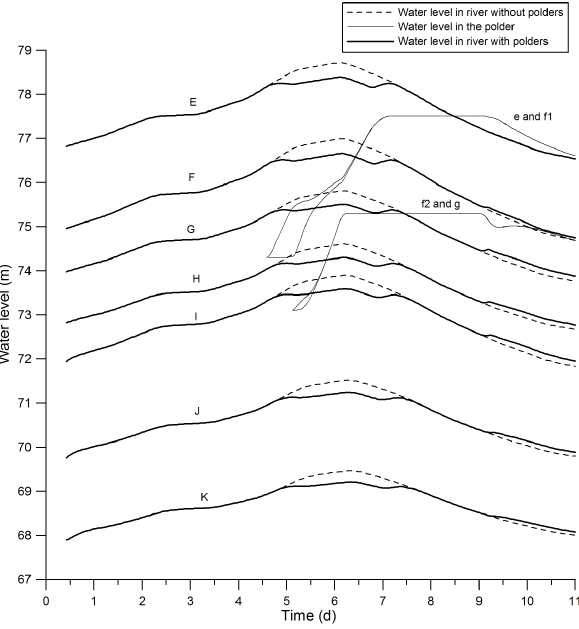
Fig. 11. Water levels in the river and polder system P1+P3 with the weir breadth of 50m. See Fig. 3 for river locations E to K.